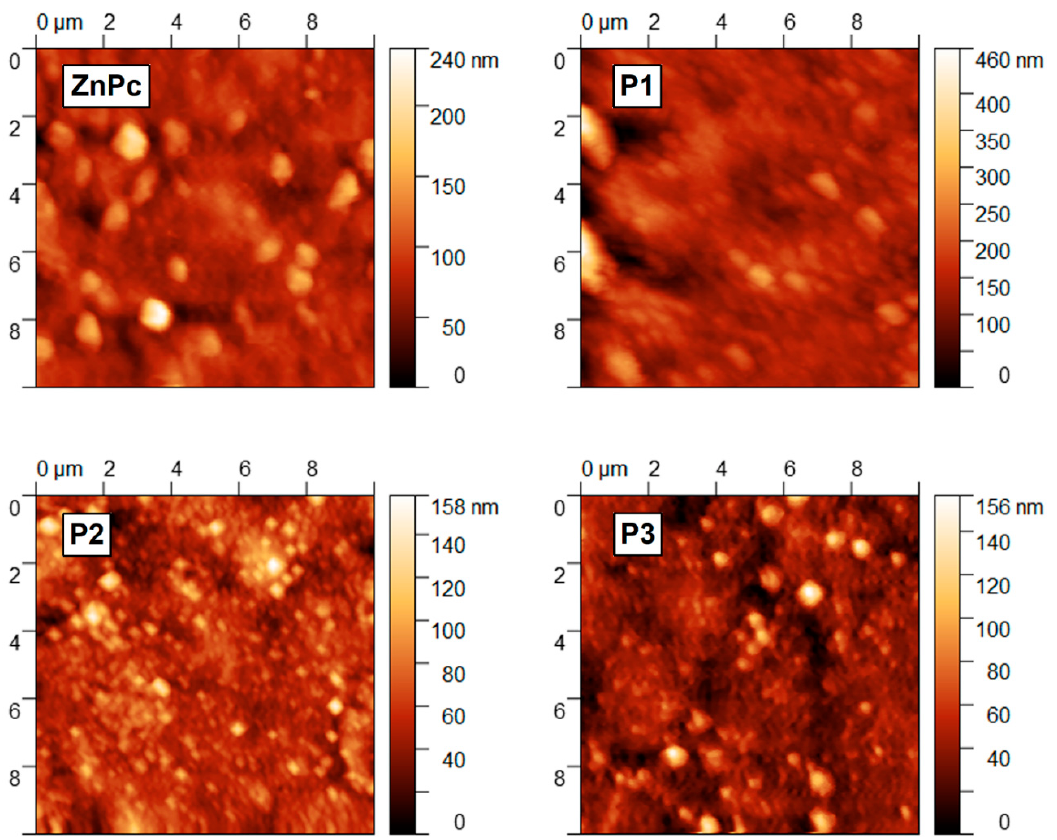
Figure 5. AFM images of the of the MAPLE-deposited organic layers on ITO/PEDOT:PSS.